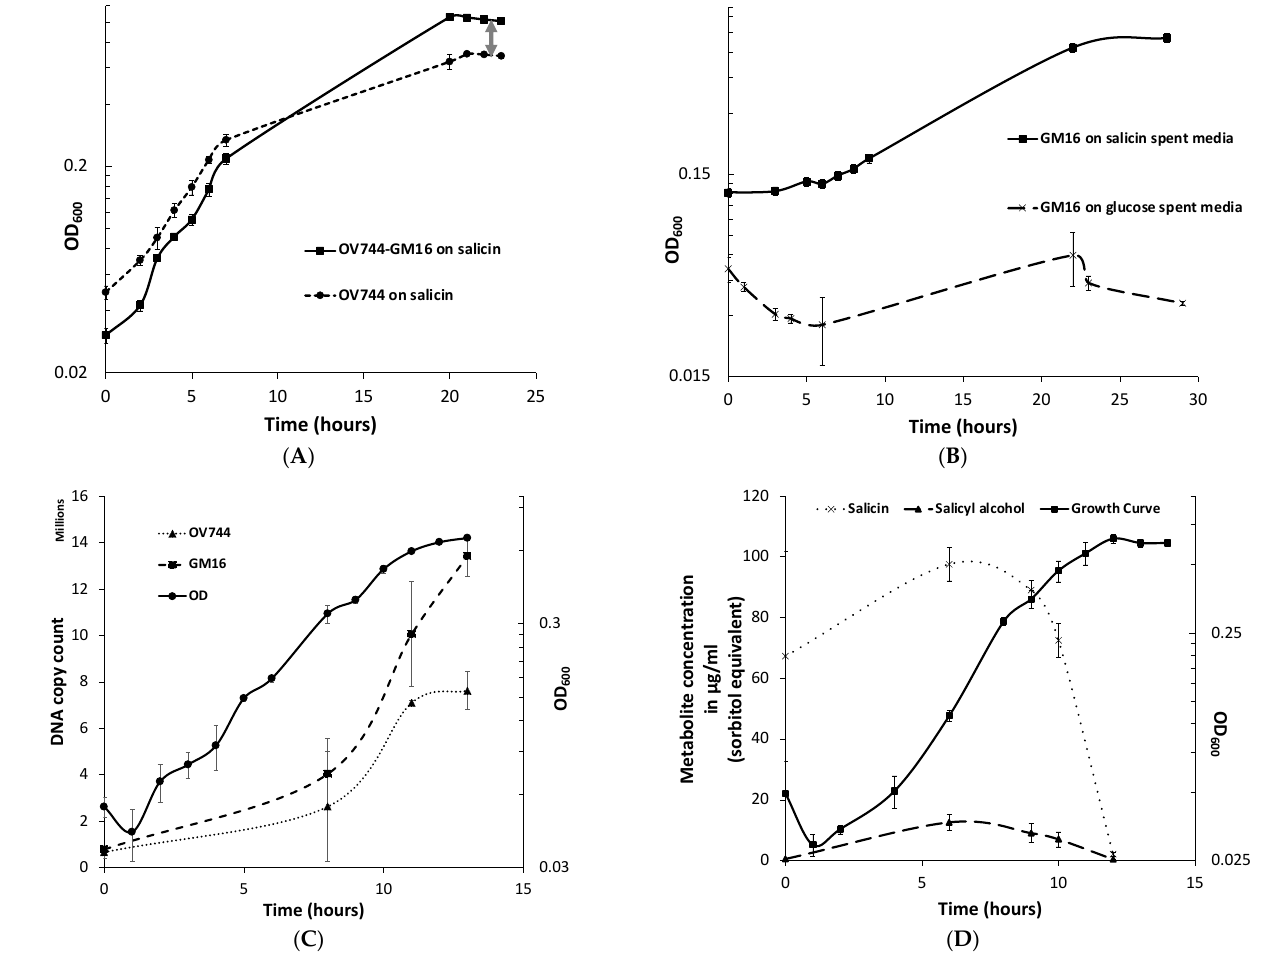
Figure 3. R. aquatilis OV744 and P. fluorescens GM16 can both grow on salicin co-culture by cross- feeding salicyl alcohol. ( A ) When Rahnella was co-cultured with Pseudomonas on salicin, a spike in OD600 (visualized by double-arrowed line) was observed compared to the OD 600 of Rahnella salicin monoculture. ( B ) Pseudomonas was inoculated with Rahnella -grown salicin and glucose spent media. Pseudomonas was not able to utilize the spent medium from glucose culture, but it could use spent medium from salicin culture. ( C ) A qPCR experiment was performed to monitor the growth of individual strains in salicin co-culture. As the co-culture grew (as monitored by OD 600 ), both Rahnella and Pseudomonas were able to multiply as demonstrated by the increase in the DNA copy count of both strains. ( D ) A time-course metabolite analysis on the supernatant of salicin co-culture demonstrated decrease in salicin levels over time. The salicyl alcohol levels remained low throughout this time suggesting secreted salicyl alcohol utilization by Pseudomonas in co-culture.